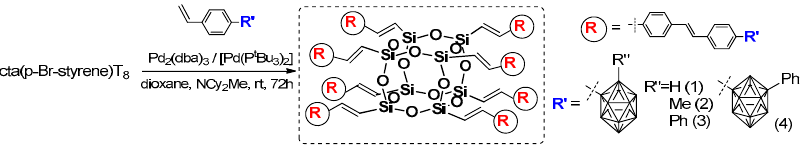
Figure 19. Synthesis of T 8 -based ortho- and metha-carboranyl-substituted vinylstilbenes.